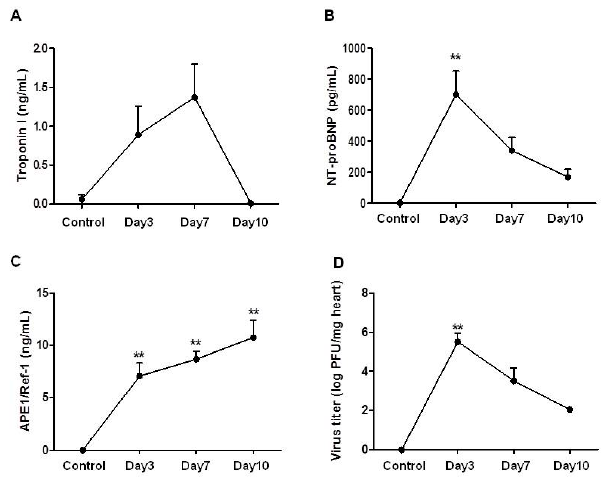
Figure 1. Changes of serum troponin I, NT-proBNP, Apurinic/apyrimidinic endonuclease 1 (APE1)/Ref-1 and heart virus titers over time in mice with acute viral myocarditis. CVB3 was injected intraperitoneally to mice. Blood and hearts were collected after 3, 7 and 10 days of infection. Serum troponin I ( A ) NT-proBNP ( B ) and APE1/Ref-1 ( C ) were increased after the infection and showed respectively different peak time at day 7, 3 and 10 post-infection. In the change of heart virus titer ( D ) maximum virus titers were found after 3 days of the infection. Since then, they had been decreased. In ( A – D ), data are presented as mean ± standard error of the mean (SEM) and analyzed by one-way ANOVA, post hoc Dunnett test ( n = 5 in control; n = 10 in day 3; n = 10 in day 7; n = 7 in day 10). ** p < 0.01 vs. control.